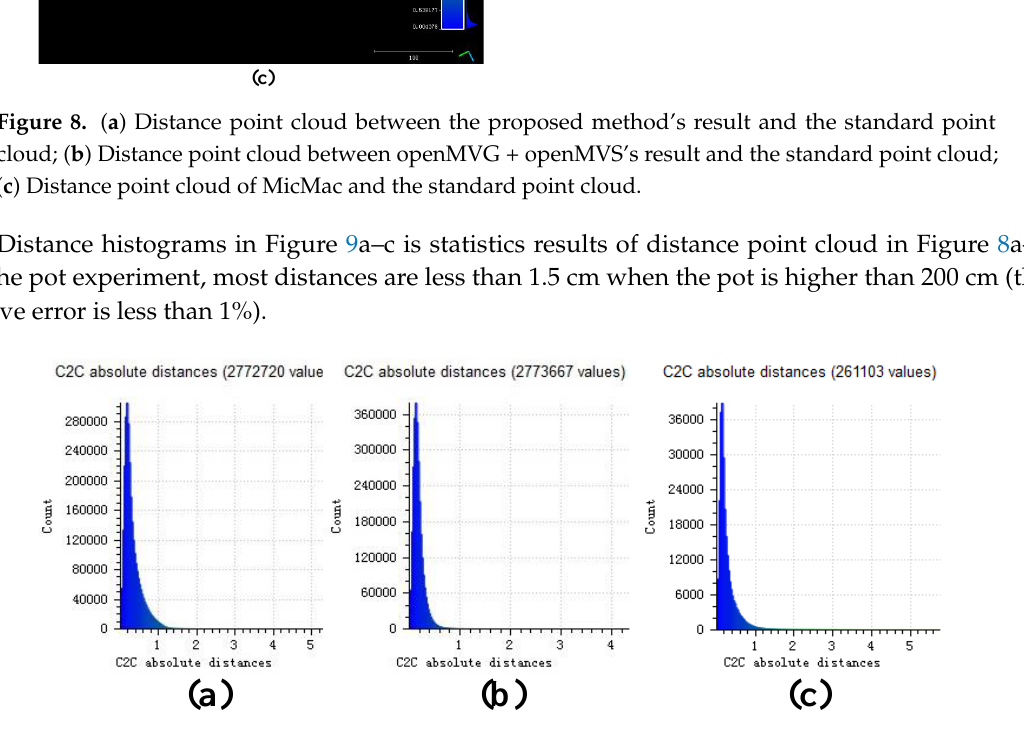
Figure 9. ( a ) Distance histogram of our result; ( b ) Distance histogram of openMVG + openMVS’s result; ( c ) Distance histogram of MicMac’s result.